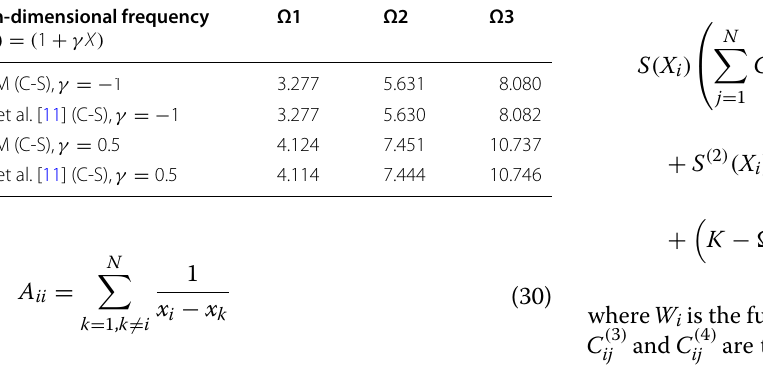
Table 3 Results of PM and DQM for the non-dimensional frequencies of clamped–clamped non-prismatic rectangular beam Non-dimensional frequency